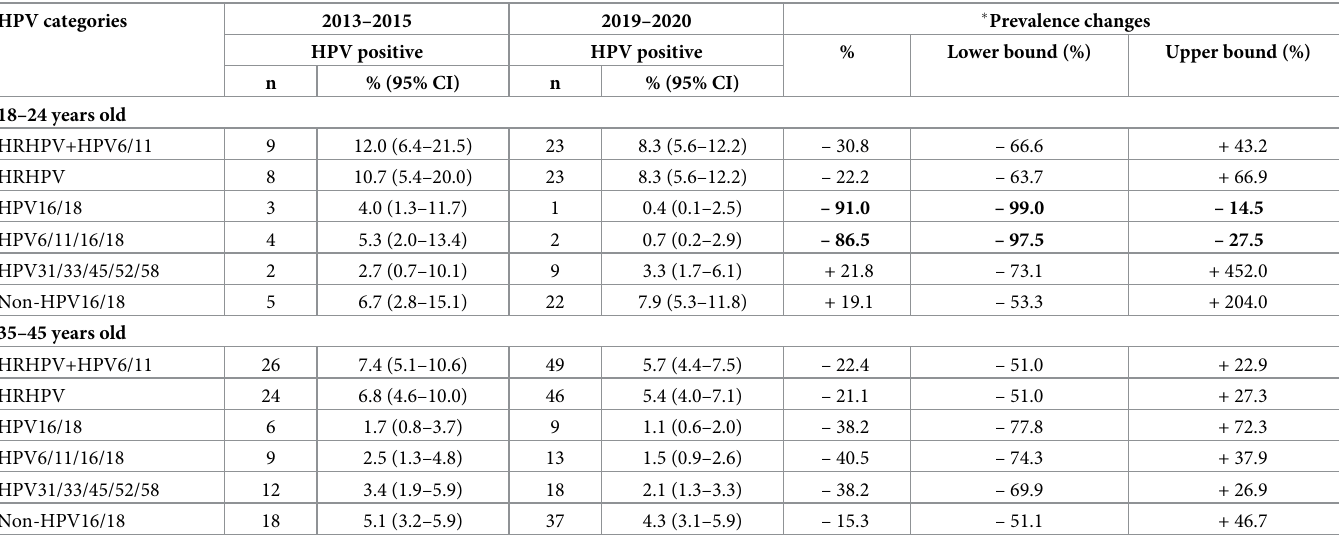
Table 2. HPV prevalence among women aged 18–24 and 35–45 by study periods.